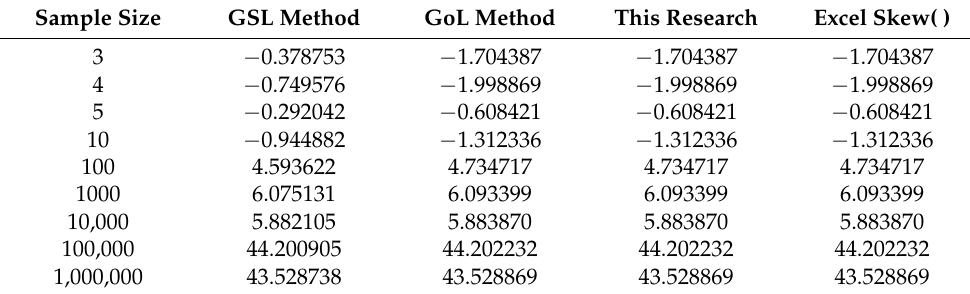
Table 2. Three Methods’ CSS Calculation Results against EXCEL